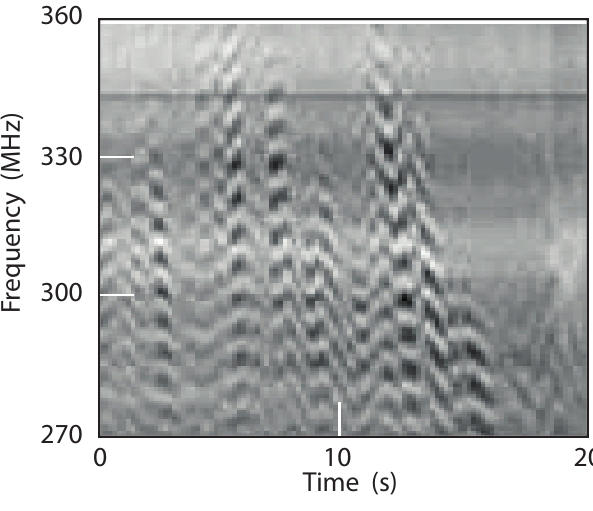
Fig. 2. The model of a post-flare magnetically trapped electron dis- tribution which is the source of type IV electron cyclotron maser radiation. In this stage the weakly relativistic hot electrons have evolved into a loss-cone distribution of Dory-Guest-Harris type with completely empty sharply edged loss cone assuming that whistler activity has ceased (simply because ω pe /ω ce (cid:28) 1 ) and quasilinear diffusion into the loss cone is terminated. The R-X mode emission is caused on the section of the resonance circle in phase space that cuts through the steep perpendicular phase space gradient of the loss cone and is mostly perpendicular to the magnetic field at frequency below but very close to the local electron cyclotron frequency. Upward directed strong electric fields at the site of the magnetic mirror accelerate cold ions into an ion-conic distribu- tion which propagates up into the configuration and generates large numbers of ion cyclotron harmonics. The local modulation of the electron loss cone distribution by the ion wave spectrum modulates the electron cyclotron maser and causes the genuine ion-harmonic spaced ‘Zebra’ emissions.